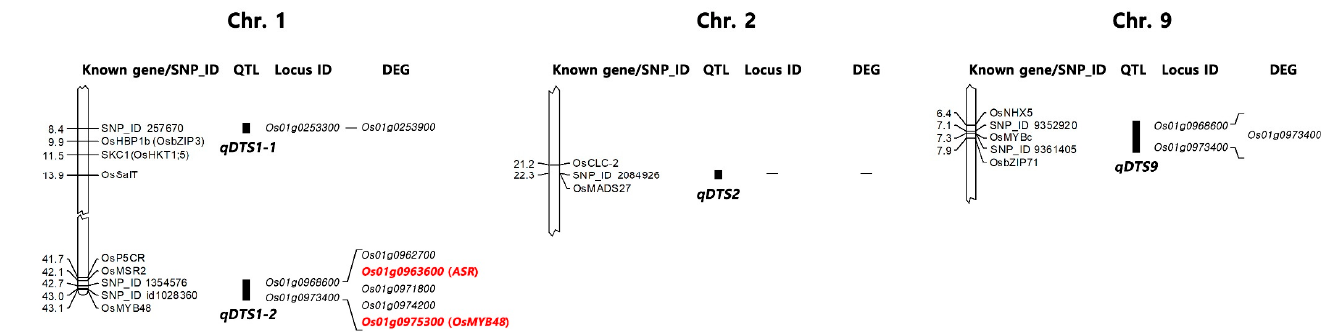
Figure 5. The physical location of QTLs is associated with salt tolerance at the seedling stage on chromosomes 1, 2, and 9, respectively. Known gene/SNP_ID: Known genes related to salt tolerance closely located to the QTLs are represented in the gene symbols, and the SNP marker used for GWAS in this study is represented in SNP_ID. QTL: QTLs related to salt tolerance were identified in this study. Locus ID: Significant SNPs related to salt tolerance were identified by GWAS in this study. DEG: DEGs identified in this study are represented in locus ID. Two upregulated genes under salt stress are represented in red. The physical map distance is represented in Mb.